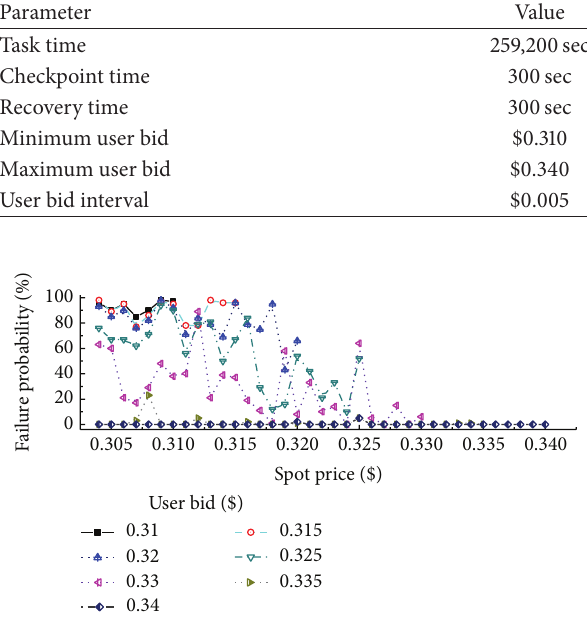
Figure 11: Failure occurrence probability.